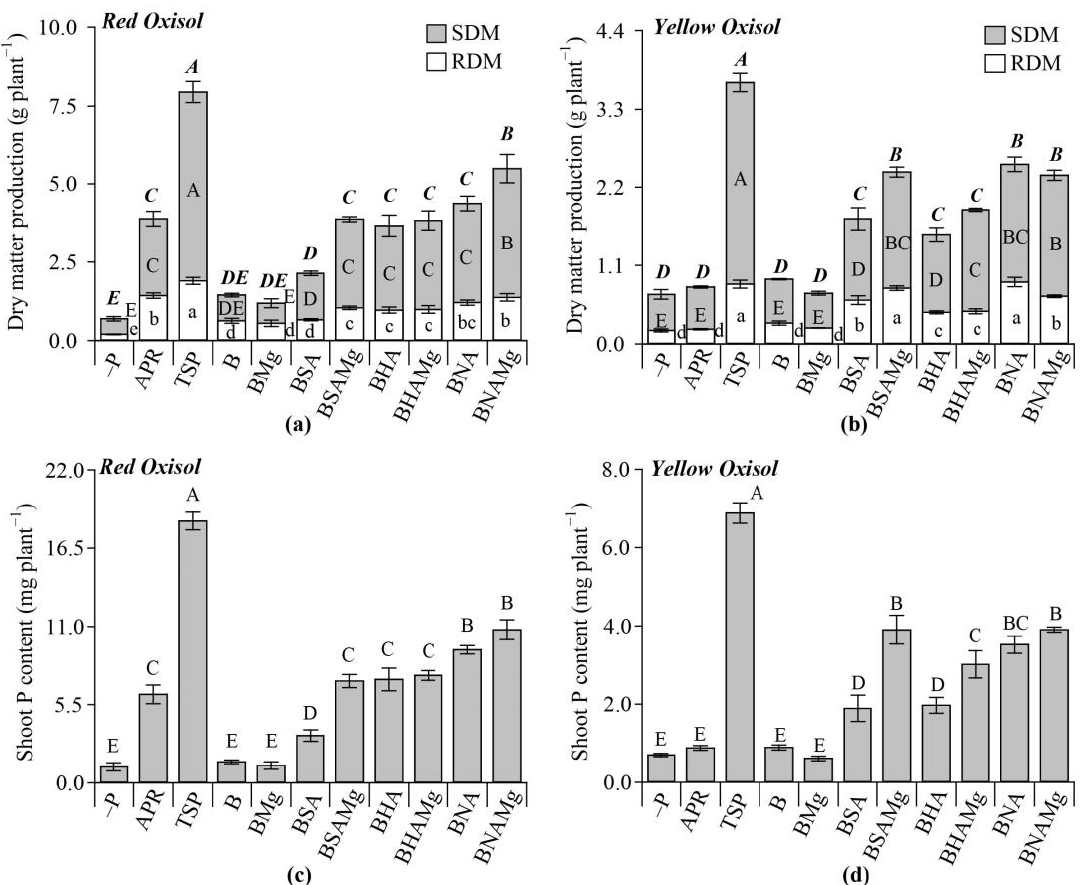
Figure 6. Biomass production ( a , b ) and phosphorus (P) accumulated in maize shoot ( c , d ) for plants cultivated in the Red and Yellow Oxisols. The bars with standard error followed by the same bold italic, capital, and same lowercase letter did not differ regarding the treatment means, respectively, for total (full bar), shoot (SDM), and root (RDM) dry matter, according to the Duncan test ( p < 0.05). The bars with standard error followed by the same uppercase letter did not differ regarding the treatment means for P accumulated in maize shoot, according to the Duncan test ( p < 0.05). –P: no P fertilizer used in the maize cultivation; TSP: triple superphosphate; APR: Arax á phosphate rock. More details of the BBFs acronyms and synthesis routes are shown in Table